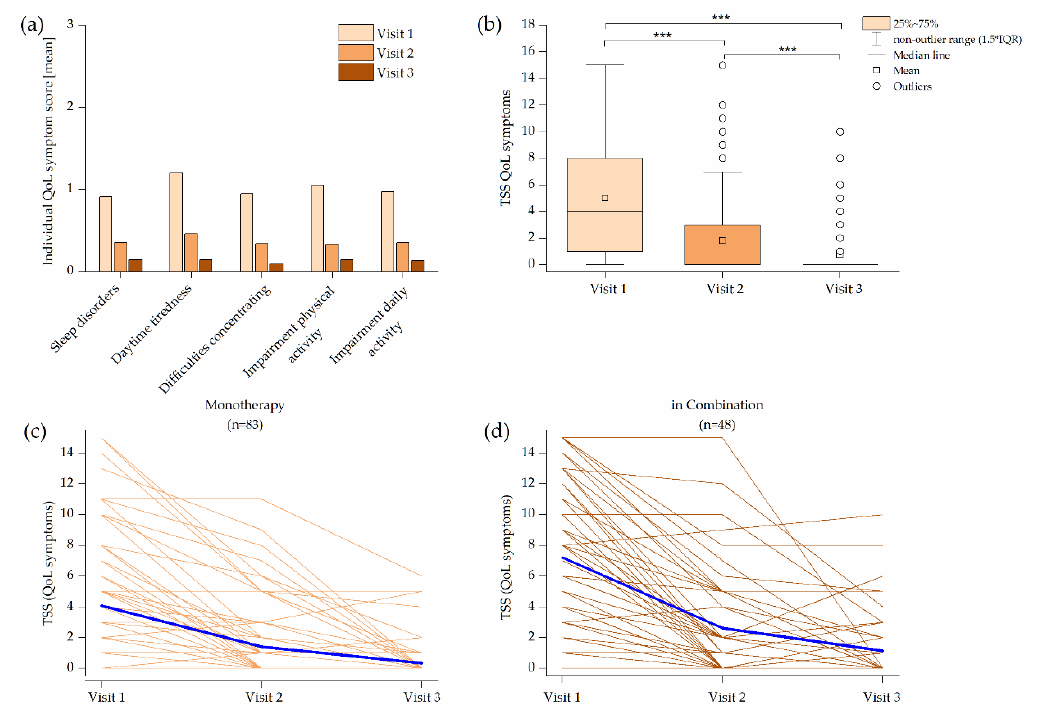
Figure 7. Impact on quality of life (QoL) items: ( a ) individual QoL items between visits; (b) box plot of the QoL total symptom score (TSS); ( c ) time course of the individual QoL TSS values for subjects with Ze 339 monotherapy; ( d ) time course of the individual QoL TSS for subjects with concomitant therapy. Blue lines indicate the mean of the TSS.